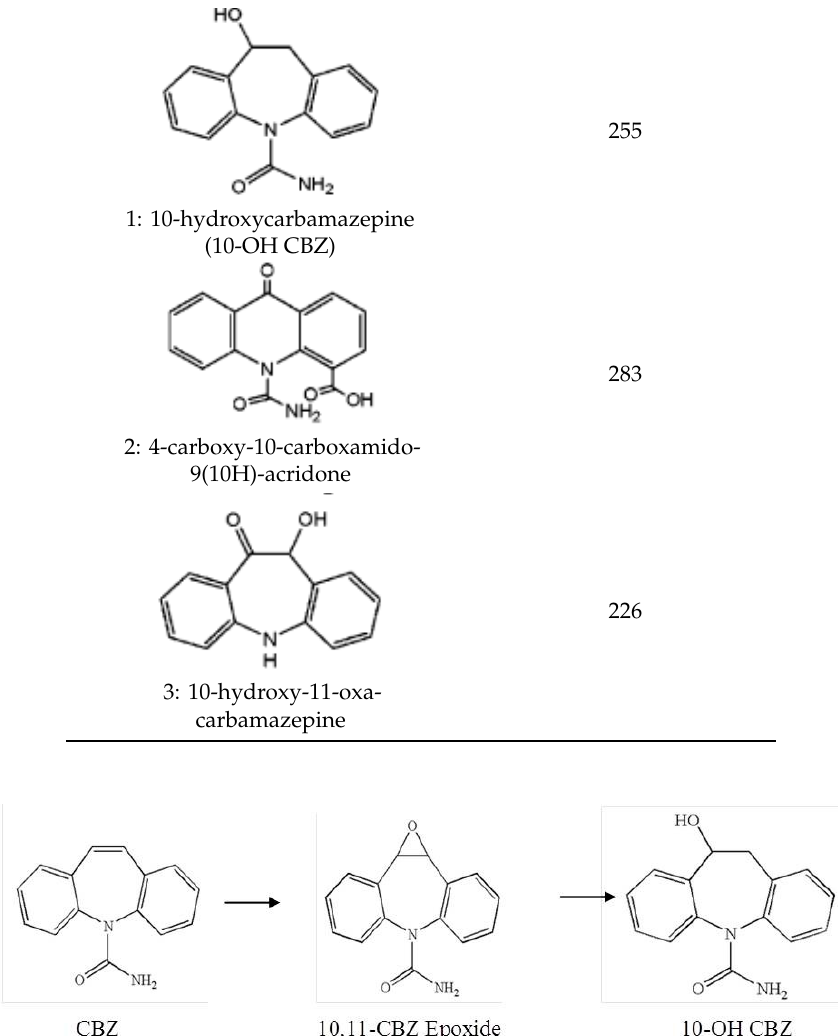
Figure 7. Proposed oxidation reaction of CBZ by A. braunii and the formation of 10-OH CBZ.